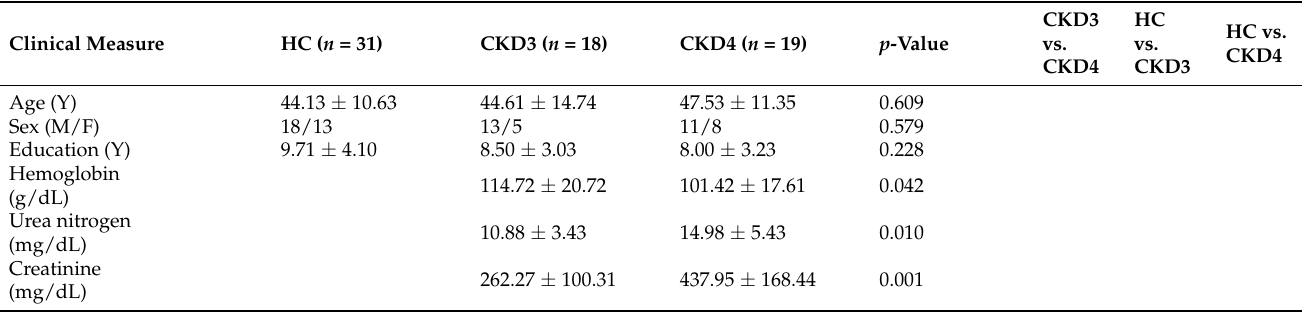
Table 1. Demographics, neuropsychological tests, and laboratory results of CKD3, CKD4 patients, and